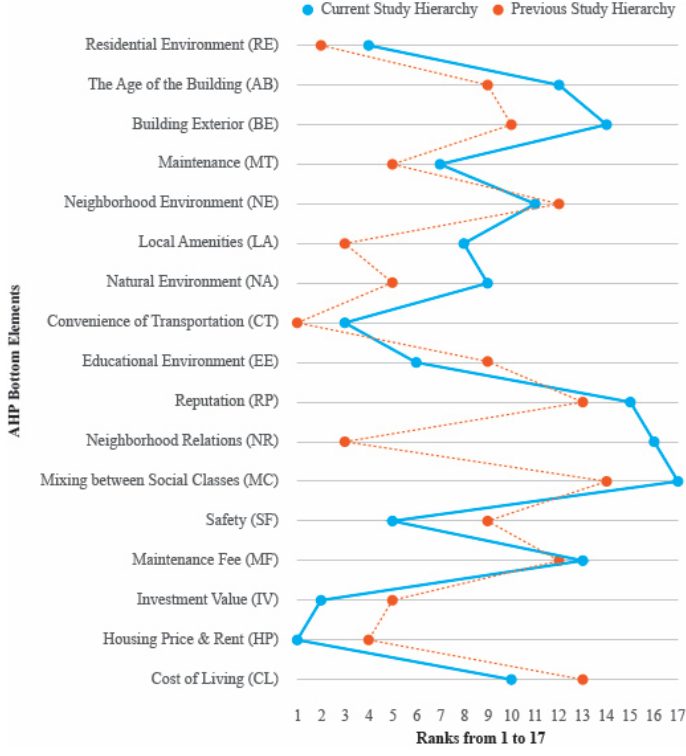
Figure 3. The Comparative Analysis of Hierarchy.